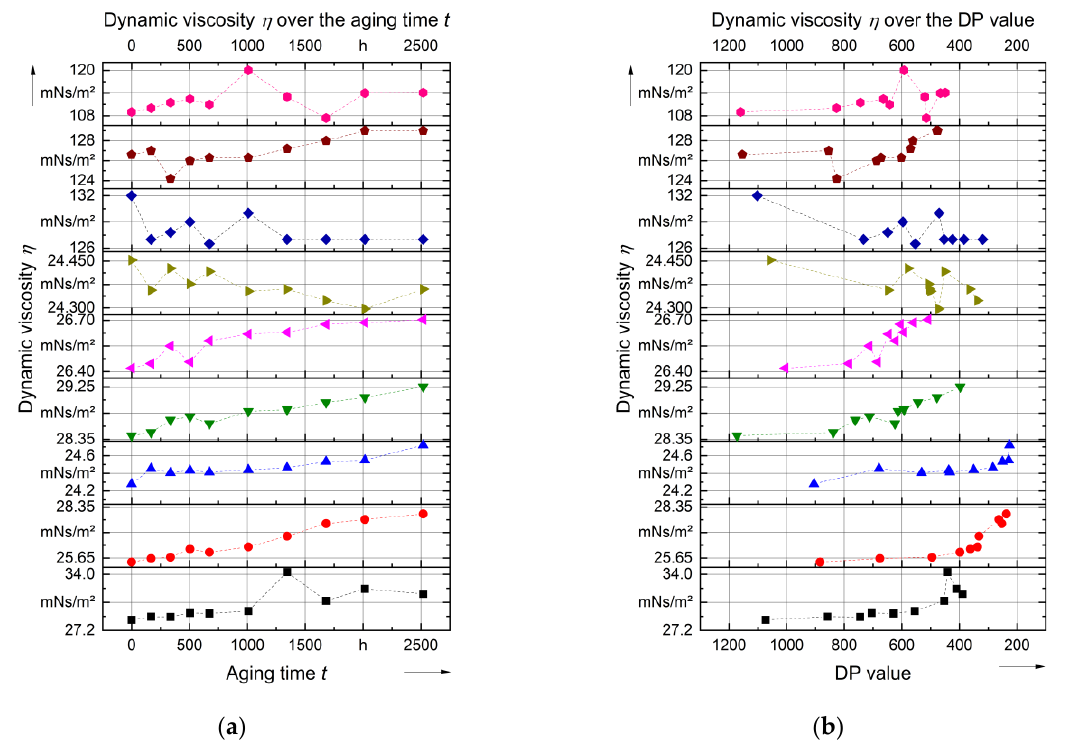
Figure 15. Change of dynamic viscosity η at 10 °C for different sealing systems and fluids: ( a ) Change over the aging time; ( b ) Change over the DP value; the legends refer to Figure 6a.